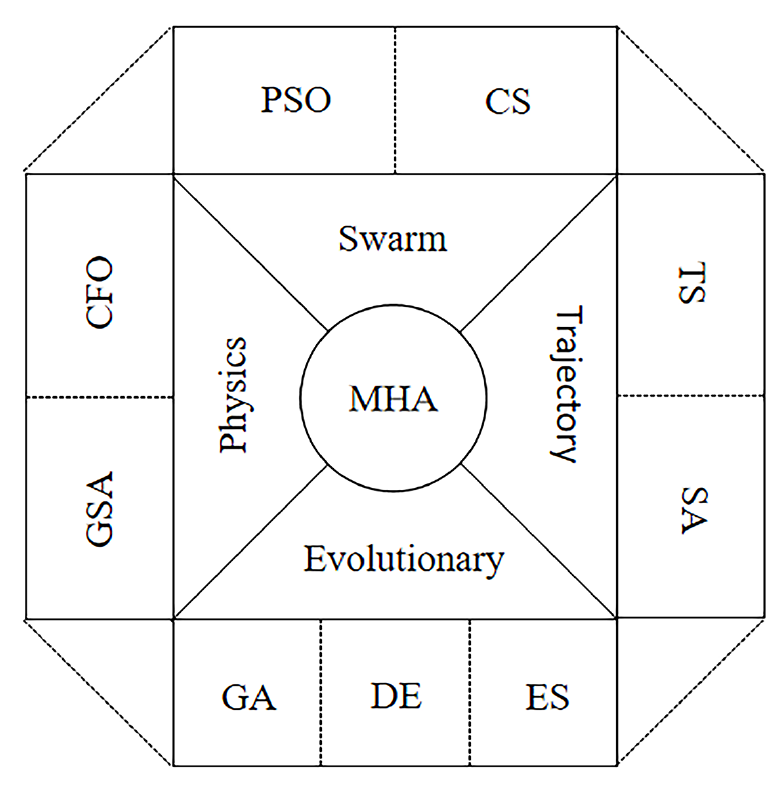
Figure 1. Classification of metaheuristic